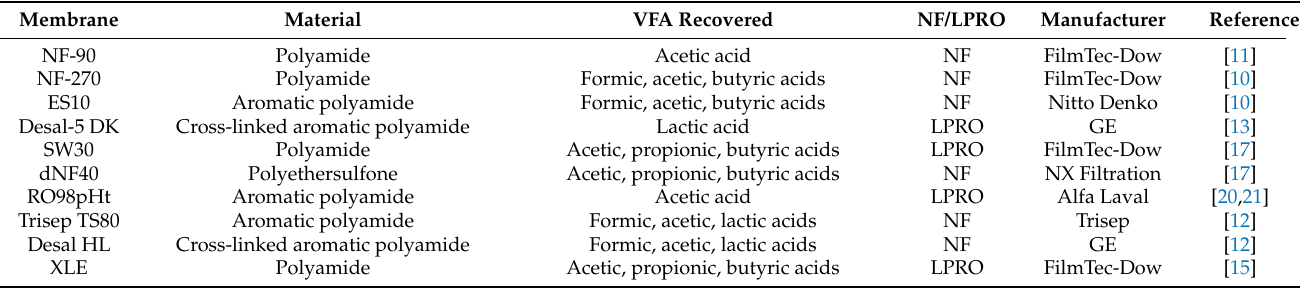
Table 1. Membranes used for VFAs